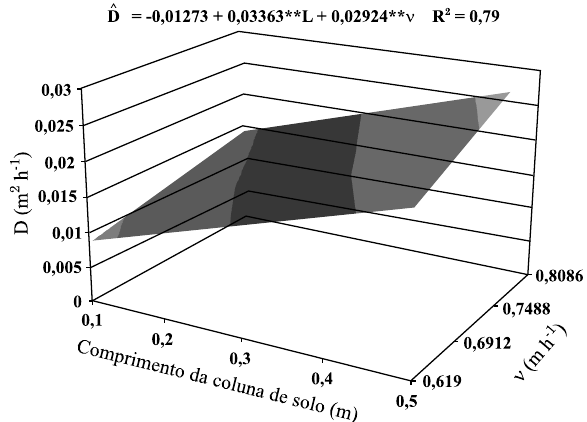
Figura 3. Estimativas do coeficiente de dispersão- difusão (D) de potássio num Latossolo Vermelho distrófico (LVd), em função de colunas de solo com 0,10 a 0,50 m de comprimento (L) e de velocidades de escoamento da solução ( ) de 0,62